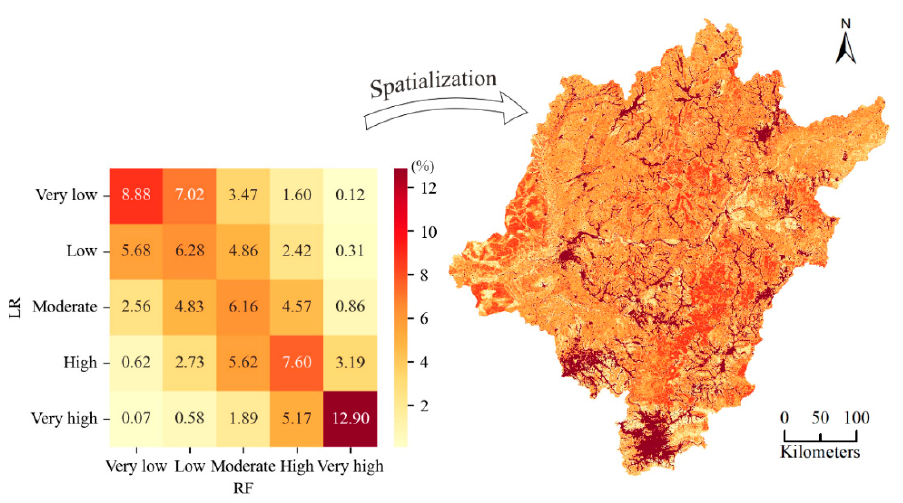
Figure 11. The susceptibility classes in the two susceptibility maps were cross-counted to obtain the corresponding pixel proportions, and the corresponding colors were assigned to the superimposed susceptibility maps to derive the spatial distribution.